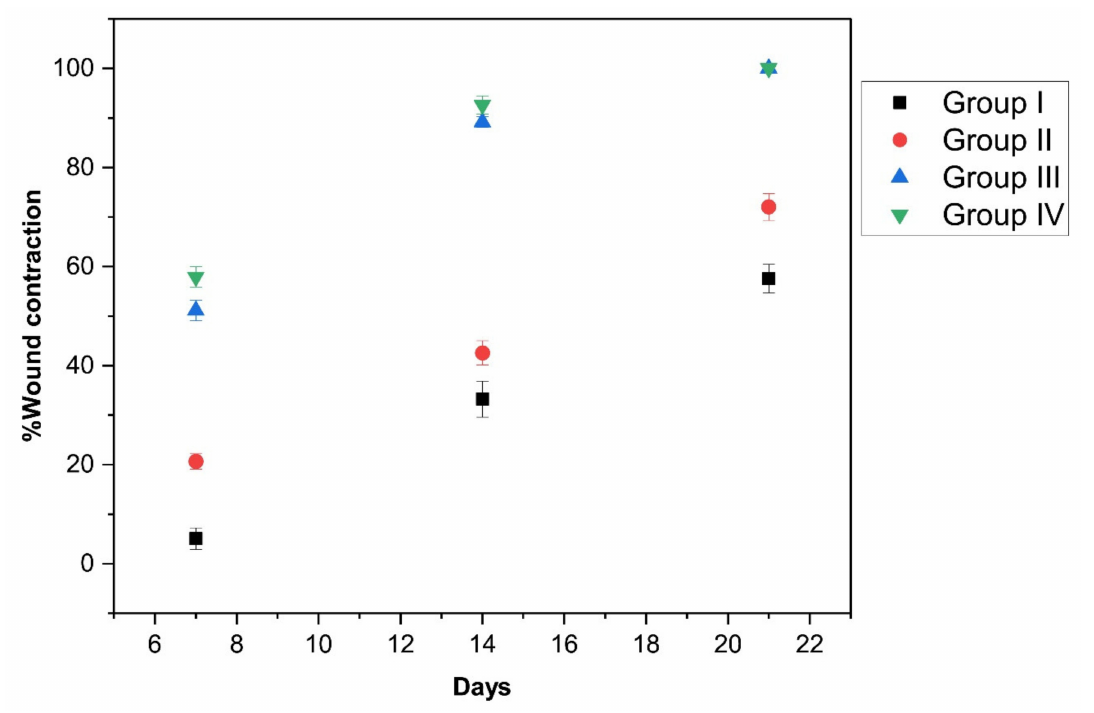
Figure 8. Percentage of contracted wound area in different treatment groups (group I, II, III, and IV) of animals.